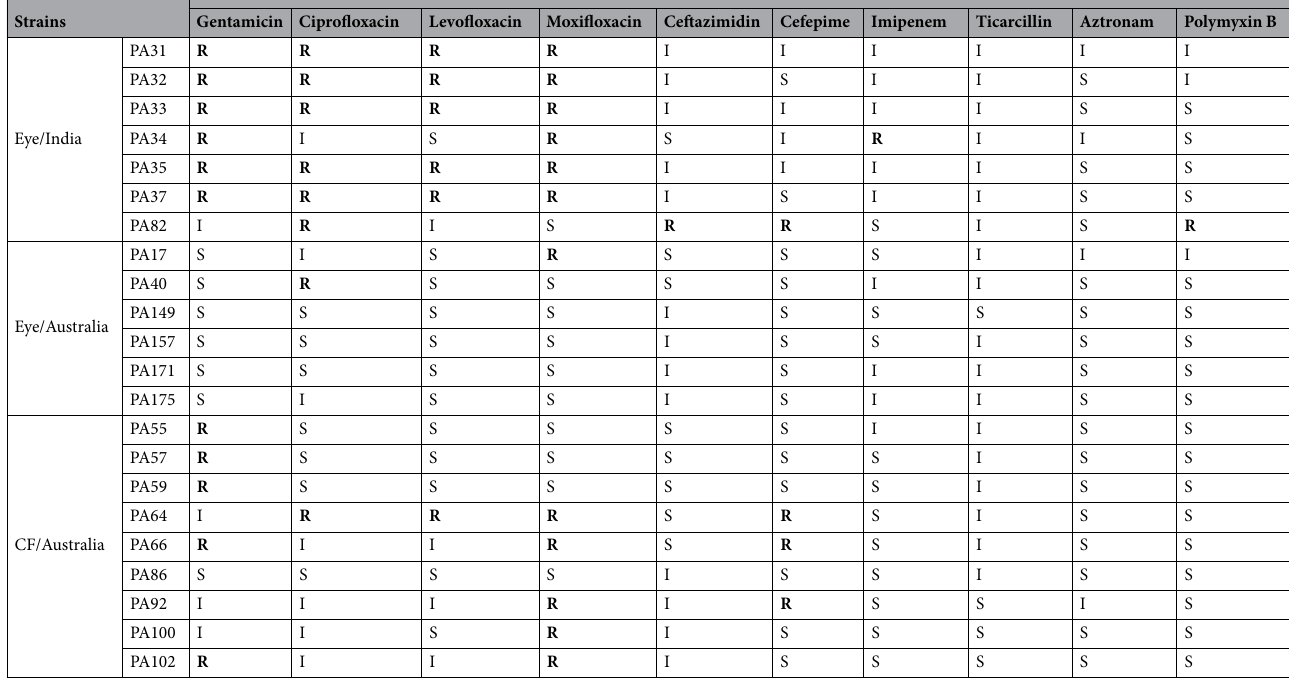
Table 2. Antibiotic susceptibility profile of P . aeruginosa